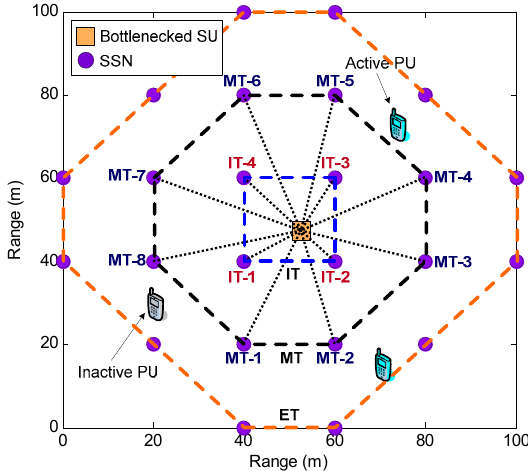
Figure 5. Simulation scenario: the rectangular grid topology with three-tier structure within a torus area of 100 m × 100 m. The dotted lines correspond to the transmissions of the spectrum sensing results from interior tier (IT) and middle tier (MT) spectrum sensor nodes to bottlenecked secondary user. SU: secondary user; PU: primary user; ET: exterior tier.